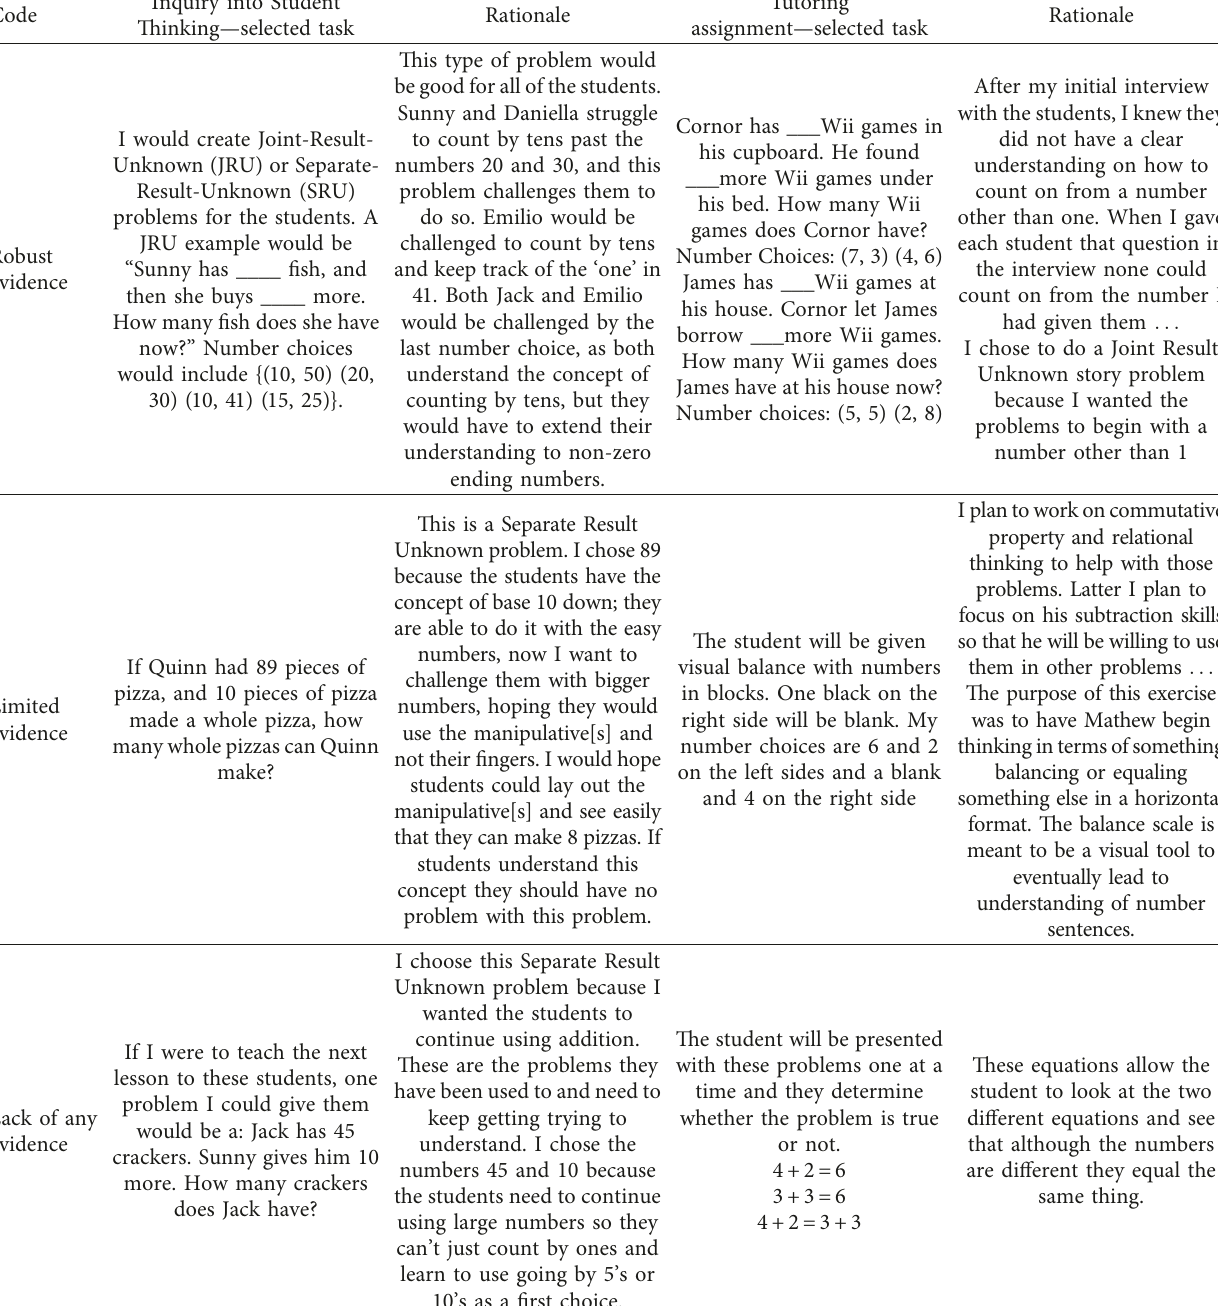
Table 4: Examples of responses coded as robust, limited, and lack of